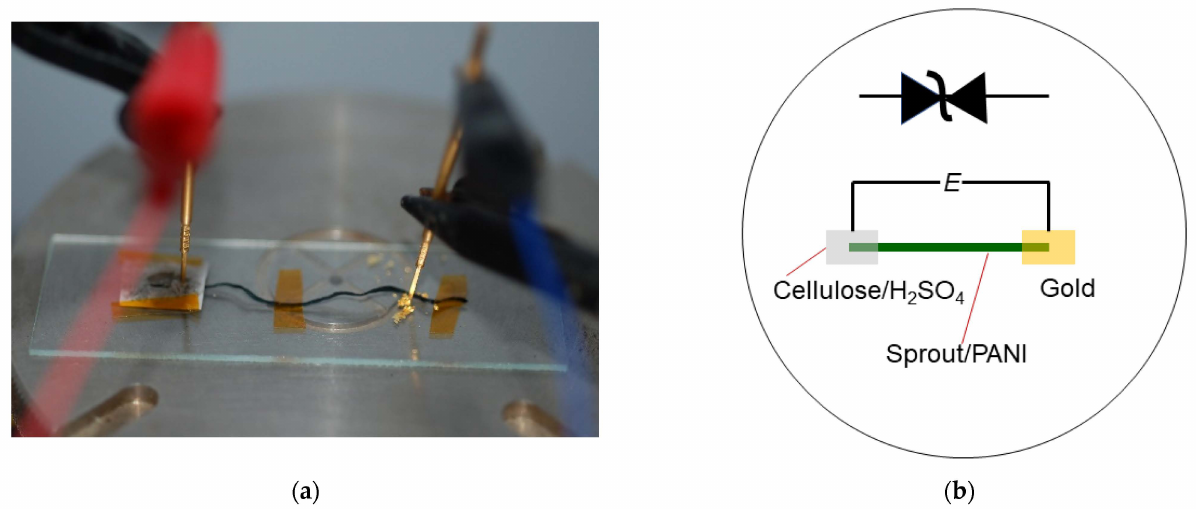
Figure 21. ( a ) Setup of sprout/PANI based electrochemical diode. ( b ) Electronic symbol and circuit of the sprout/PANI electrochemical diode.